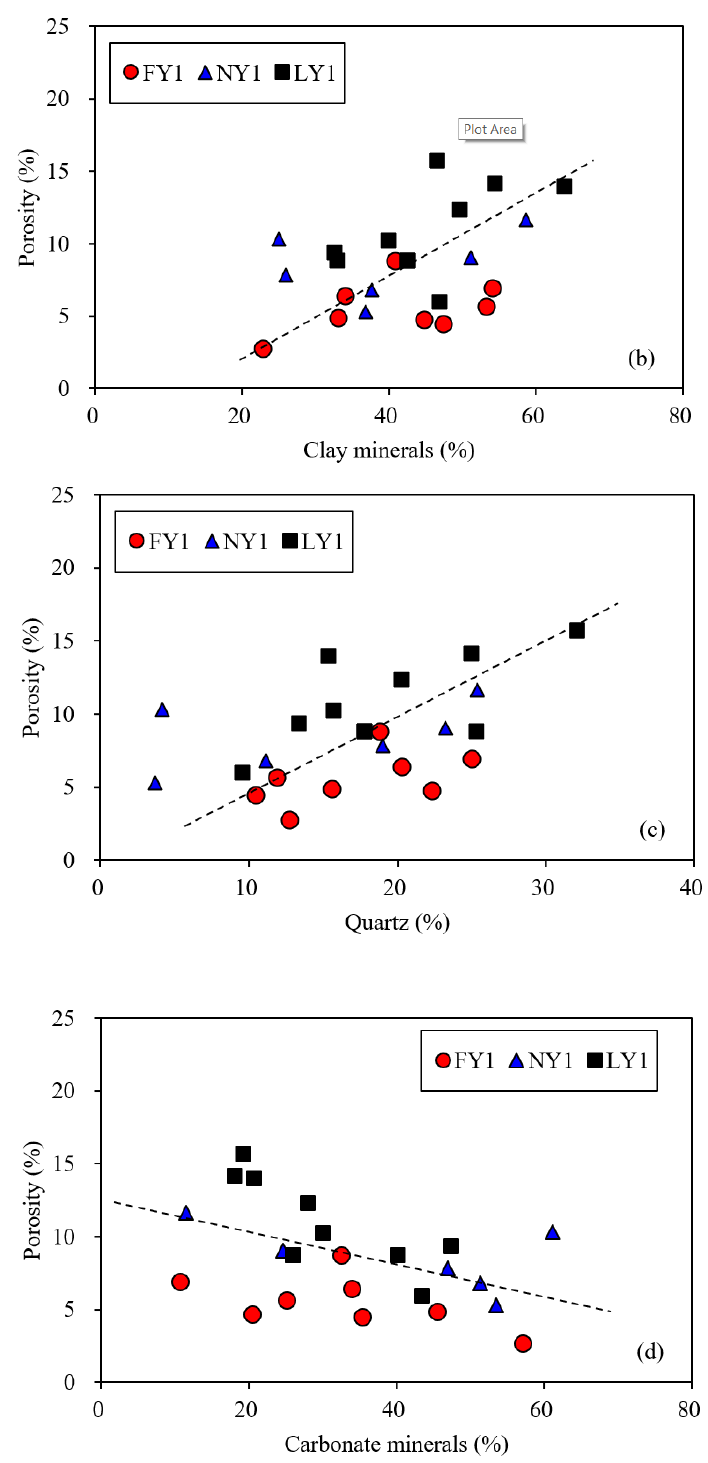
Figure 12. Plots showing relationships of porosity with TOC ( a ) and different minerals ( b – d ) for the studied samples.